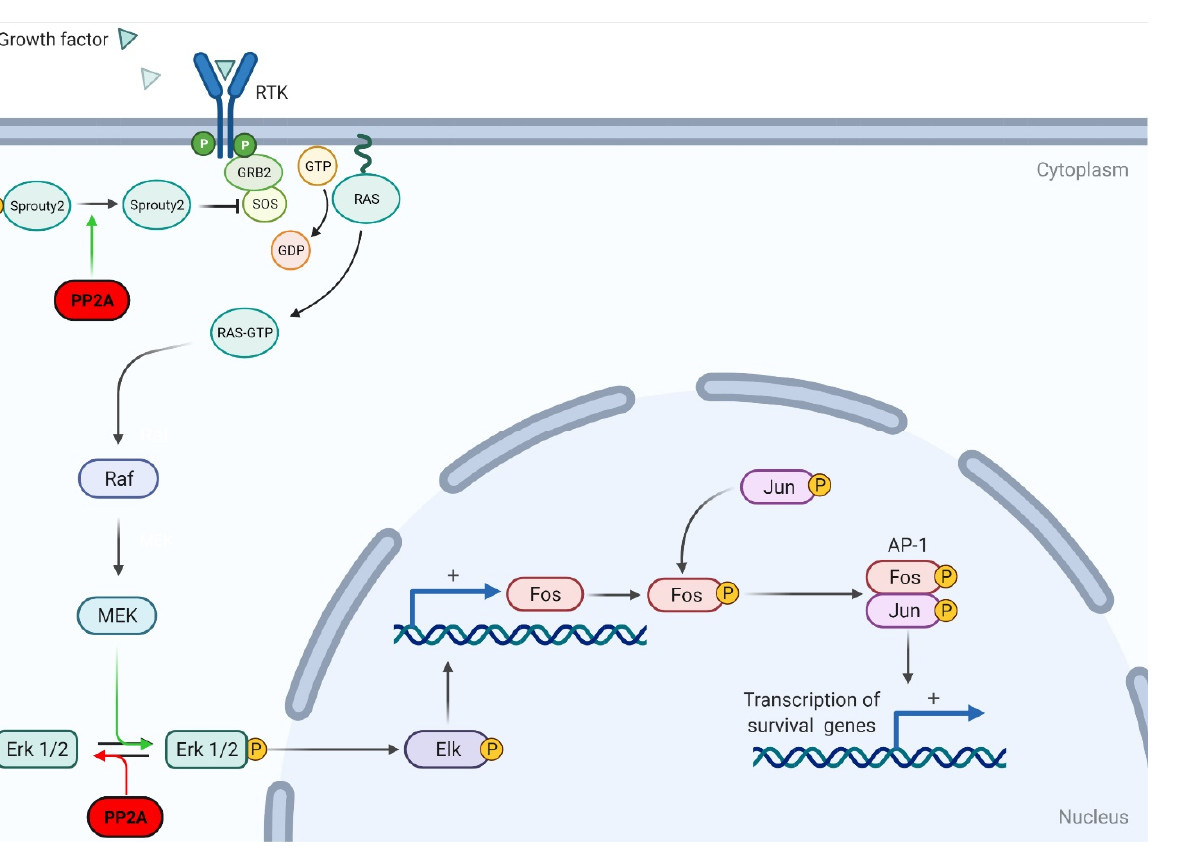
Figure 3. Schematic representation of PP2A regulation on the MAPK pathway. PP2A can dephosphorylate Sprouty2, thus inhibiting RTK-dependent activation of the MAPK/Erk pathway. PP2A can also dephosphorylate Erk1/2, preventing the activation of downstream effector Elk and preventing the transcription of transcription factors Fos and Jun. Adapted from “Ras Activation,” by BioRender.com (2021). Retrieved from https://app.biorender.com/biorender-templates, accessed on 11 May 2021.